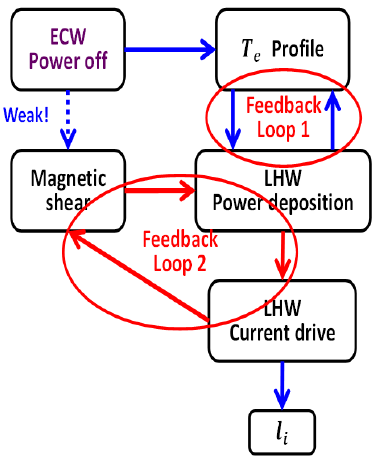
Fig. 17. Feedback mechanisms based on parametric dependences of LHW